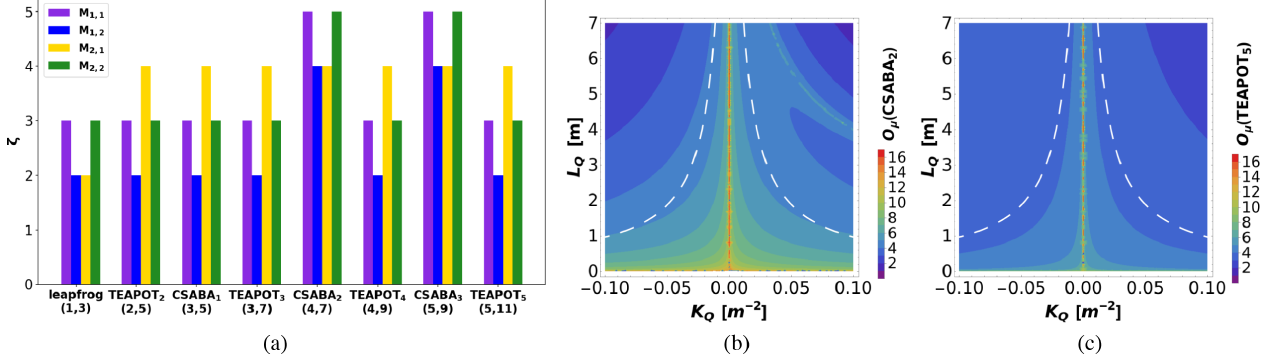
FIG. 1. (a) The order of accuracy ζ for each element M numbers in the labels inside the parentheses ( n n . The order of accuracy of μ , in a FODO cell that include dipoles, for different K tot TEAPOT 5 symplectic integrators. The area below the white dashed curve guarantees stable motion through the FODO